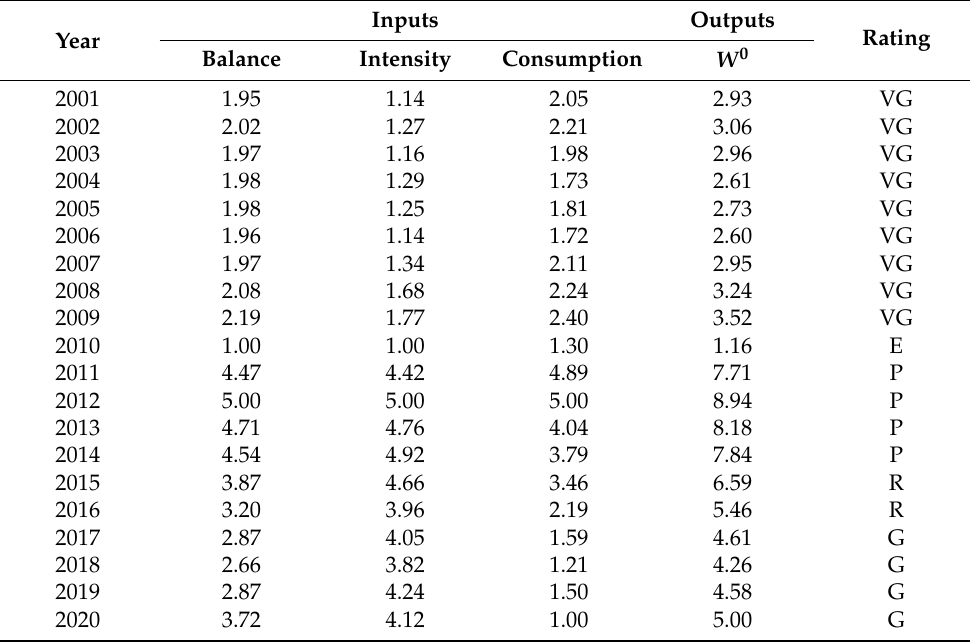
Table 1. Transport sustainability index and rating.